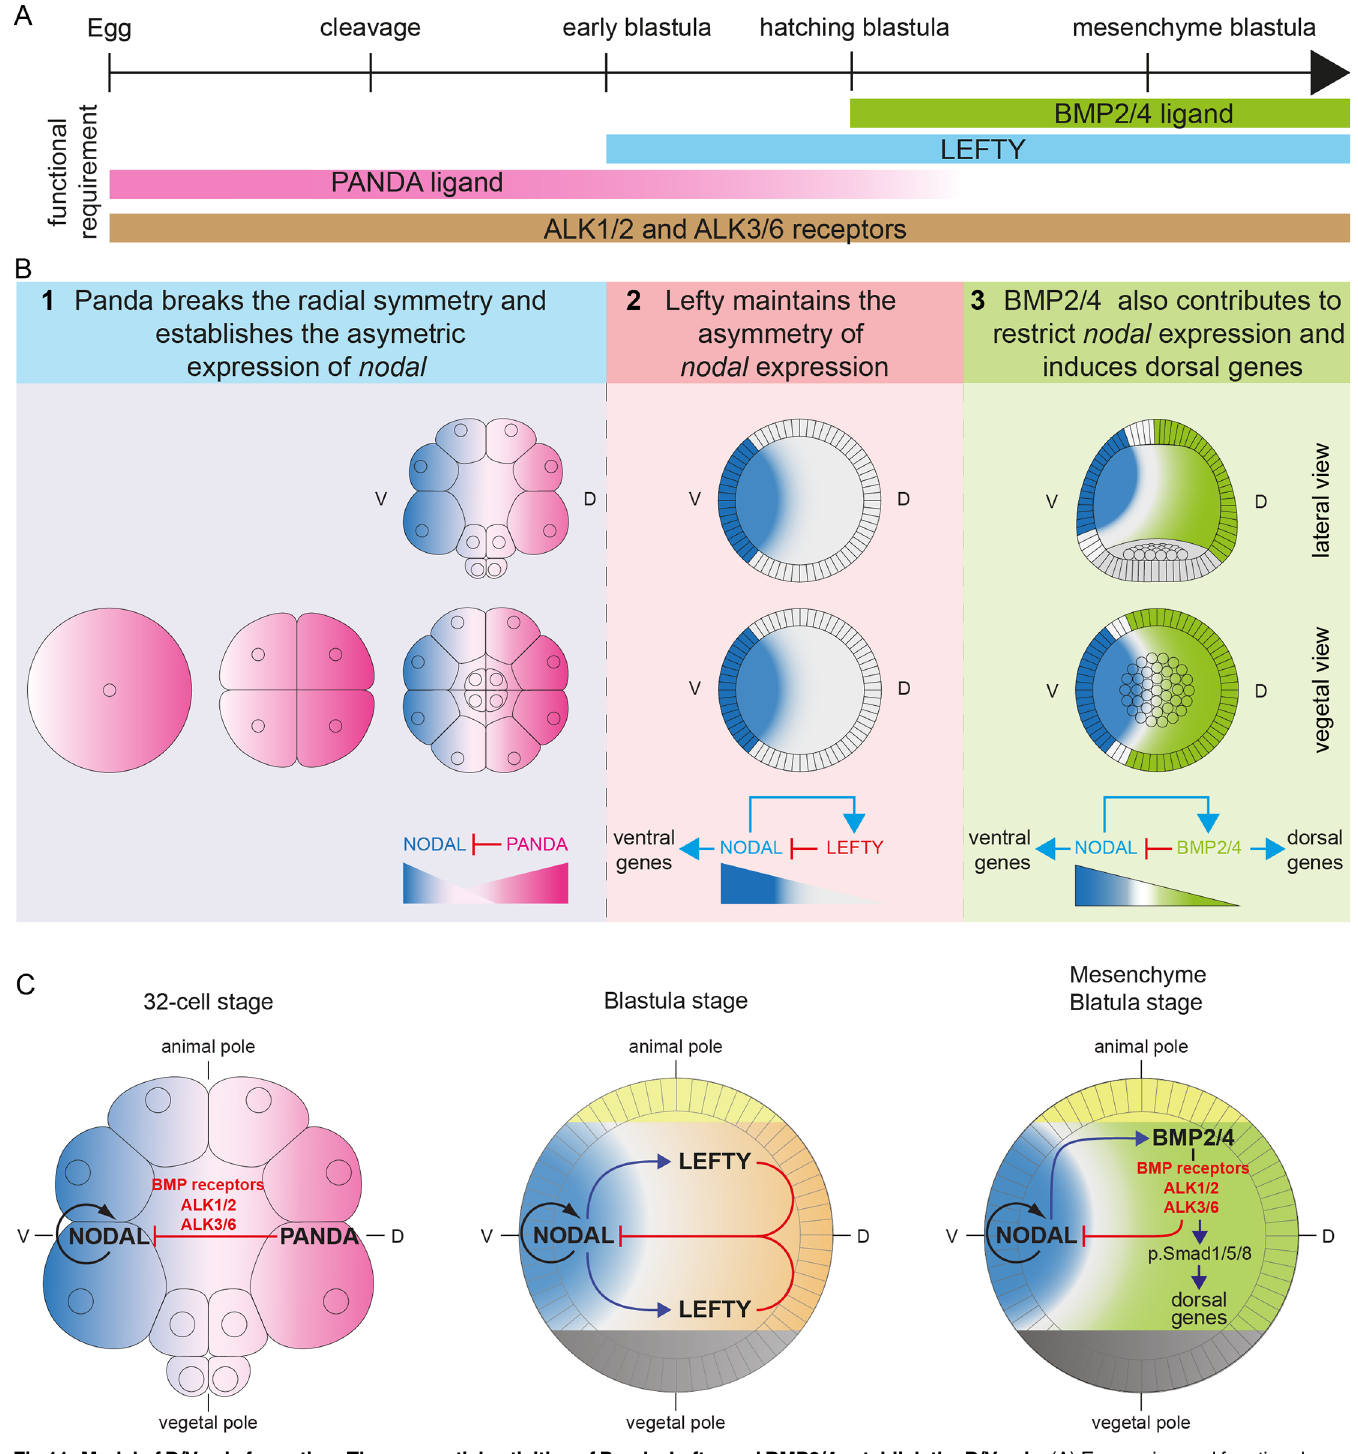
Fig 11. Model of D/V axis formation: The sequential activities of Panda, Lefty, and BMP2/4 establish the D/V axis. (A) Expression and functional requirements of the main ligands and receptors involved in D/V patterning. (B,C) The sequential activities of Panda, Lefty, and BMP2/4 progressively define the D/V axis. (1) During cleavage, a gradient of maternal Panda activity, acting through Alk3/6 and Alk1/2, first antagonizes nodal expression and breaks the radial symmetry of the embryo. (2) At the early blastula stage (7 h 30 hpf), following this initial symmetry breaking, spatially restricted Nodal induces Lefty, and Lefty, which diffuses more than Nodal, prevents Nodal autoregulation outside the presumptive ventral ectoderm. This second phase of Nodal antagonism is required to maintain the spatial restriction of nodal expression. (3) Starting at the hatching blastula stage (9 hpf), Nodal induces BMP2/4, and BMP2/4 signaling synergizes with Lefty to antagonize Nodal on the dorsal side. V, ventral; D, dorsal.